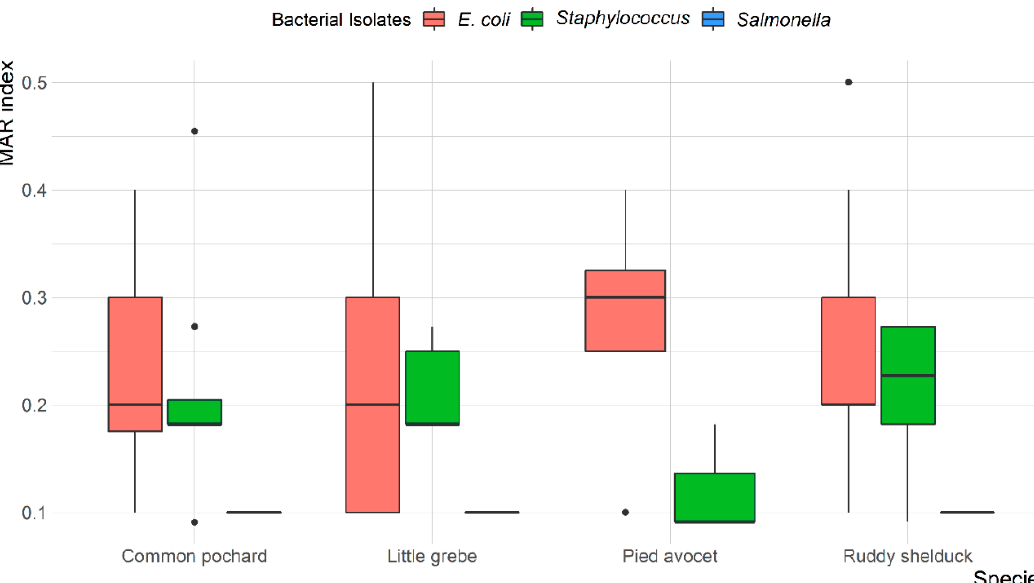
Figure 3. Spearman rank correlation test results based on the minimum inhibitory concentrations of Escherichia coli ( n = 90) isolates recovered from different species of migratory wild birds for ten antimicrobials. The blue color indicated a positive correlation, and the red shows a negative correlation. Strikes ( * ) indicate significance at p < 0.001.